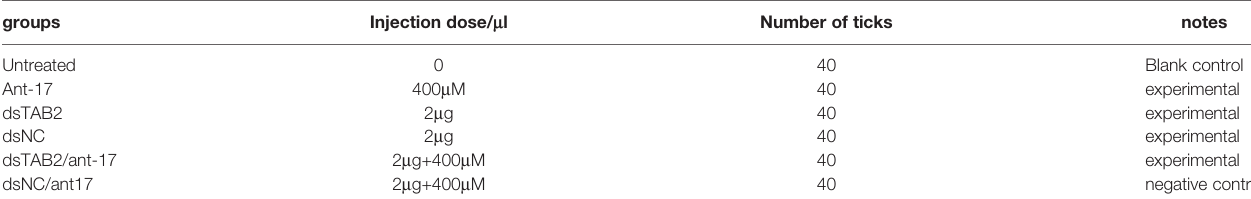
TABLE 2 | Speci fi c groups in the phenotype rescue